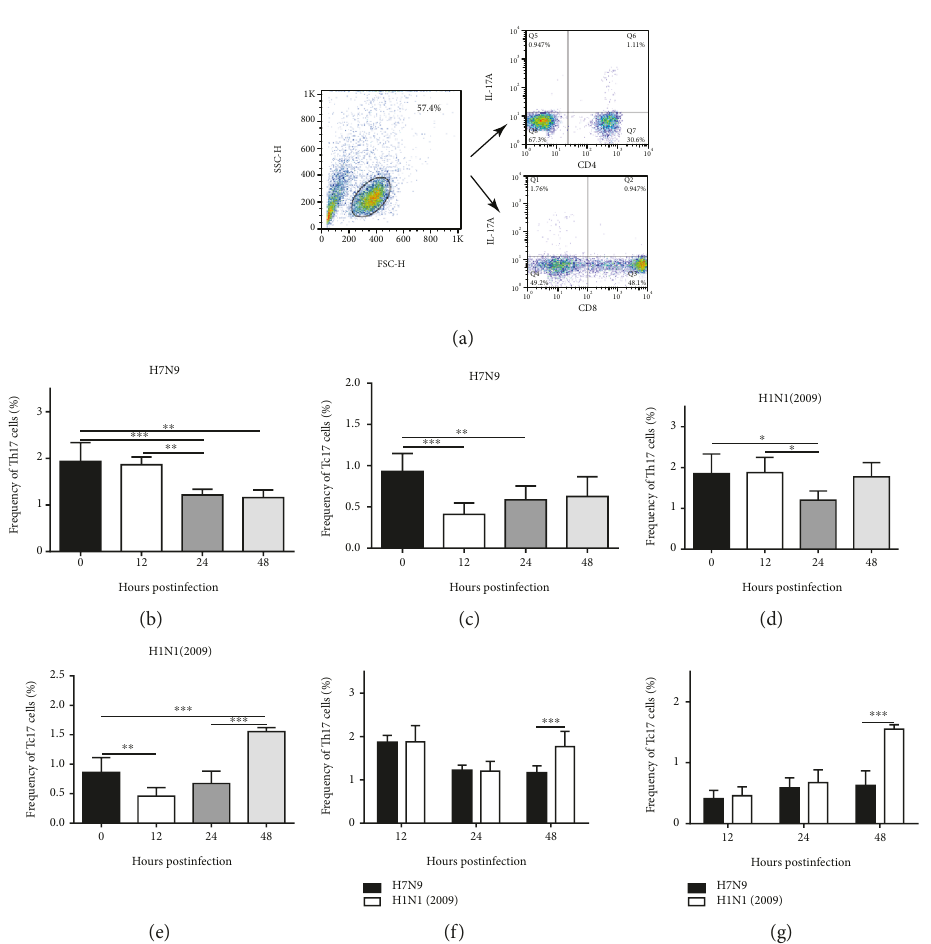
Figure 3: Decreased frequencies of Th17 and Tc17 cells among human PBMCs infected with the H7N9 virus at the indicated time points postinfection in vitro . (a) PBMCs isolated from healthy volunteers were infected with the H7N9 or H1N1(2009) virus at the indicated time points after infection; mock-infected and infected cells were gated initially for lymphocytes, and CD4 + IL-17A + (Th17) and CD8 + IL-17A + (Tc17) cells were then analyzed. (b, c) Analysis of the proportions of Th17 (b) and Tc17 (c) cells among PBMCs after H7N9 virus infection for 0, 12, 24, and 48h. (d, e) Analysis of the proportions of Th17 (d) and Tc17 (e) cells among PBMCs after H1N1(2009) virus infection for 0, 12, 24, and 48h. (f, g) Di ff erences in the frequencies of Th17 (f) and Tc17 (g) cells after H7N9 and H1N1(2009) virus infection for 0, 12, 24, and 48h. ∗ P < 0 05 , ∗∗ P < 0 01 , and ∗∗∗ P < 0 001